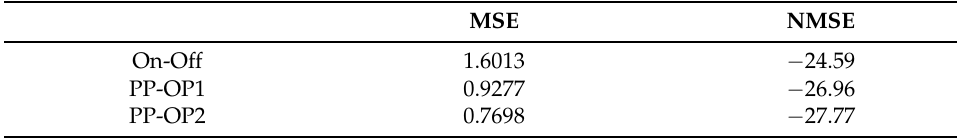
Table 1. MSE and Normalized MSE (NMSE).